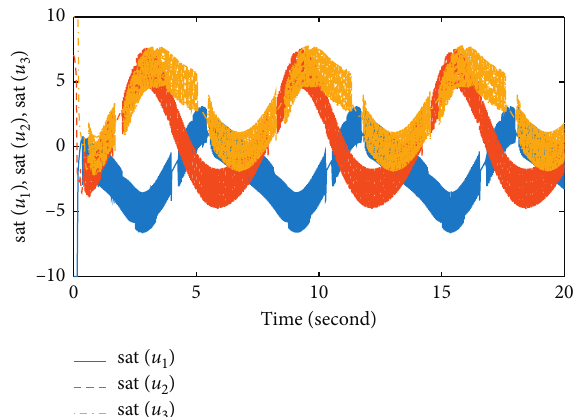
Figure 4: Case 2: the trajectories of sat ( u